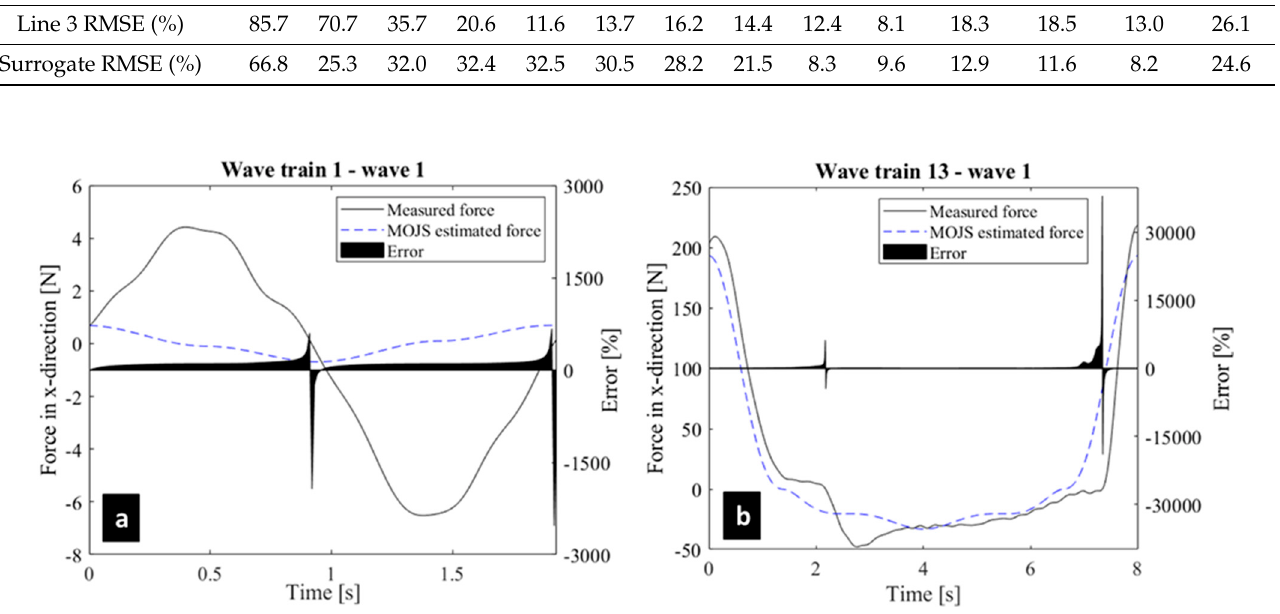
Figure 12. Force time histories of example wave cycles, comparing measured and MOJS approximated force in x-direction for line 3, ( a ) wave train 1 and wave 1, and ( b ) wave train 13 and wave 1.